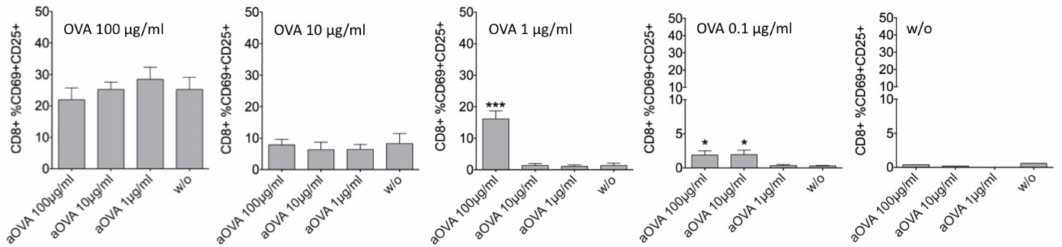
Figure 4. Immune-complexed IgG-OVA facilitates DC-mediated activation of OVA-specific OT-1 CD8 T cells. Ovalbumin (0.1, 1, 10, and 100 µ g/mL) was preincubated for 10 min either alone or in the presence of ovalbumin-specific Abs (1, 10, and 100 µ g/mL) to generate OVA-ICs. OVA or OVA-ICs were then loaded to 5 × 10 5 bmDCs and incubated overnight at 37 ◦ C. Then, bmDCs were washed and cocultured with 5 × 10 5 isolated OVA-specific CD8 TCR tg OT-1 T cells for 48 h. After 48 h of co-cultivation, activation of CD8 T cells was determined by the expression of CD25 and the early activation marker CD69 gating on AAD-negative living CD8 singlets measured by FACS. Data represent mean ± SEM of three independent experiments. Data were analyzed by GraphPad PRISM software using ANOVA followed by Dunnet’s multiple comparison test (***, **, * significant at p < 0.001, p < 0.01, p < 0.05,